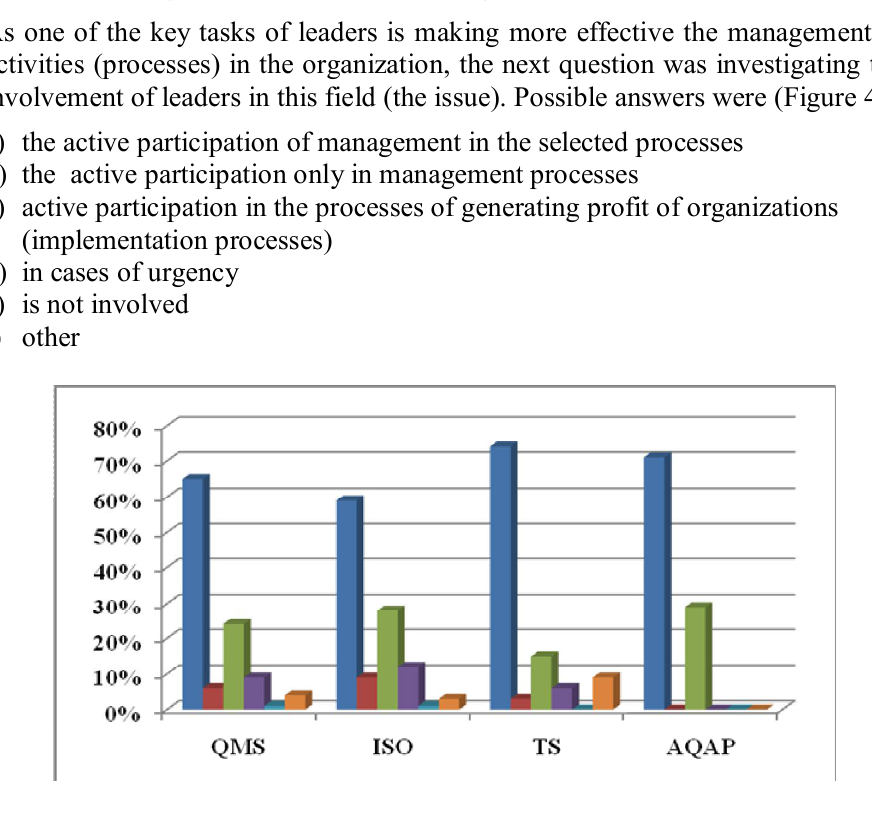
Figure 4 - Graphic representation of responses to question no.